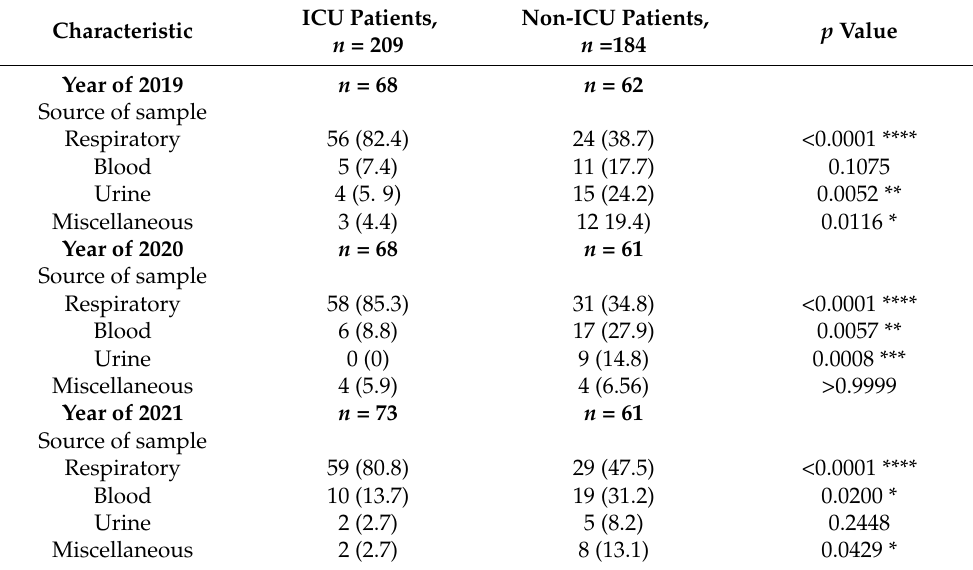
Table 5. Comparison between ICU and Non-ICU patients with S. maltophilia